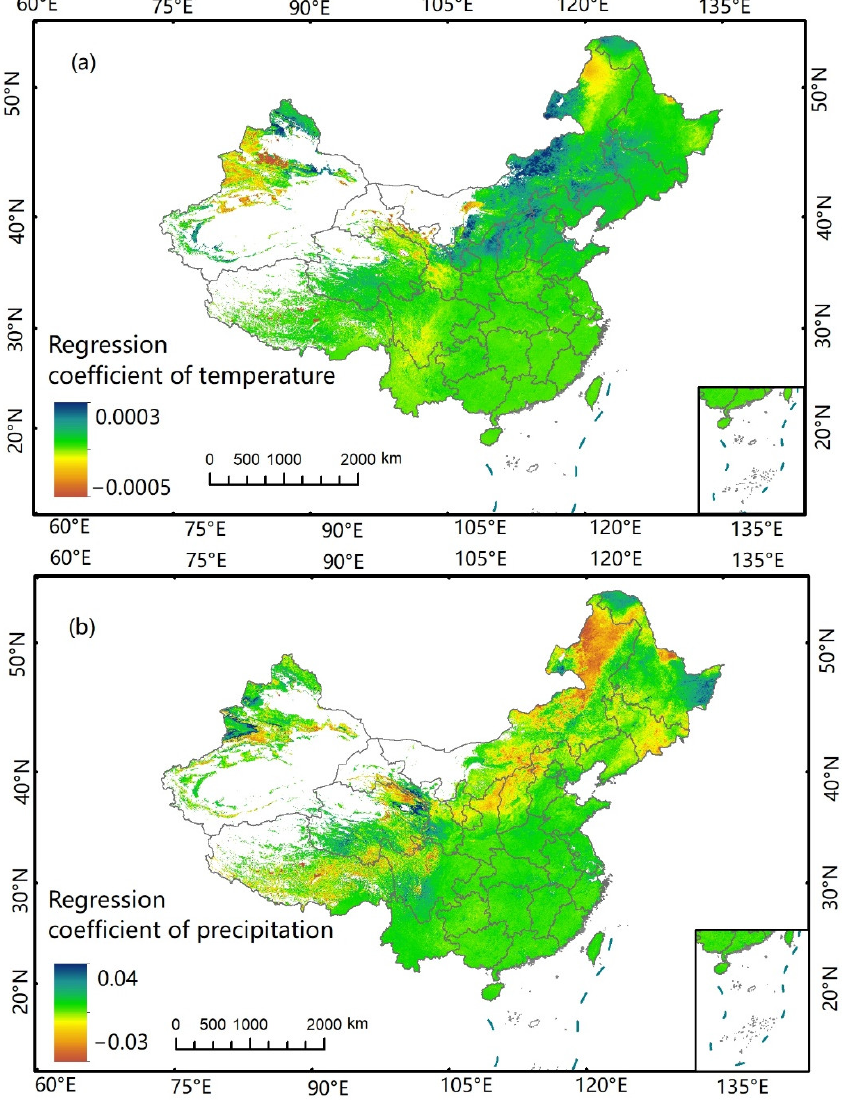
Figure 8. ( a ) Regression coefficient of temperature; ( b ) regression coefficient of precipitation, derived from multiple linear regression modelling.